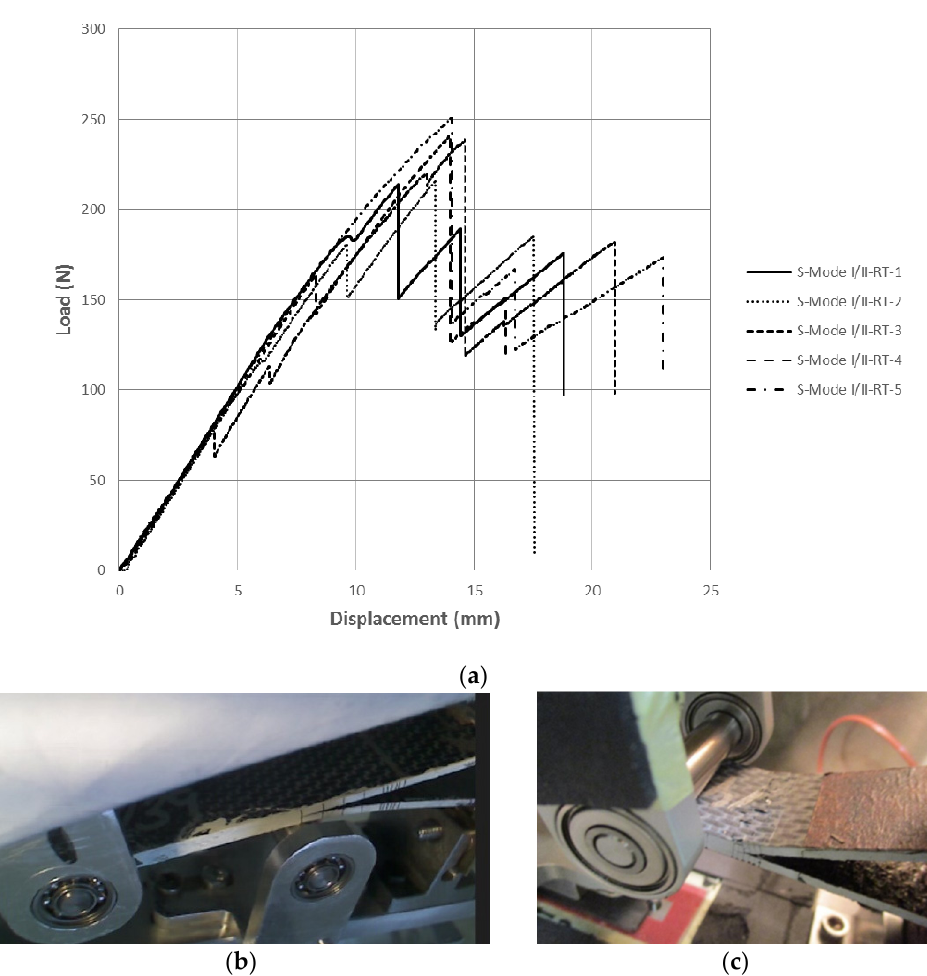
Figure 12. Mode II fracture test: ( a ) measured and predicted load vs opening displacement data RT specimens; ( b ) typical deformed shape during RT test; ( c ) failure mode at root of upper face during HW test.